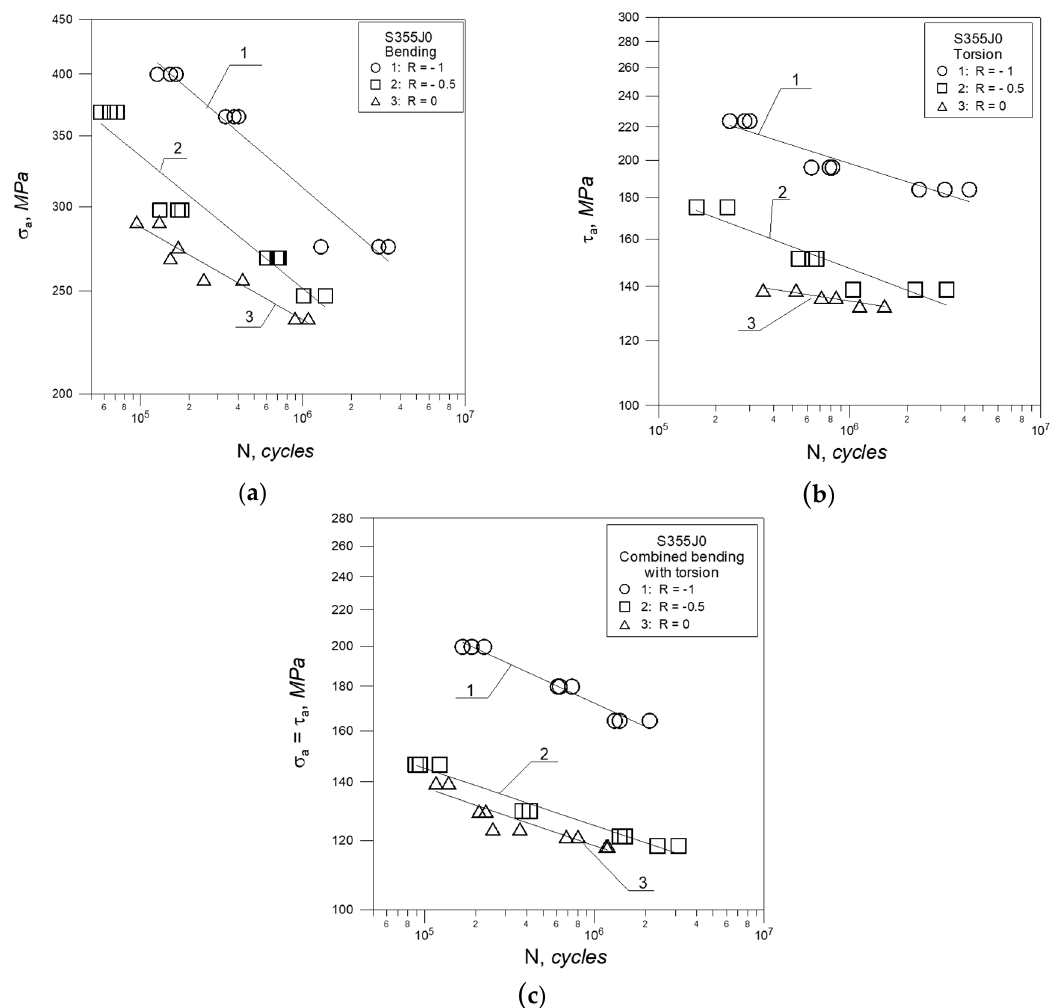
Figure 4. The results of fatigue tests on: ( a ) bending, ( b ) torsion, ( c ) bending with torsion.